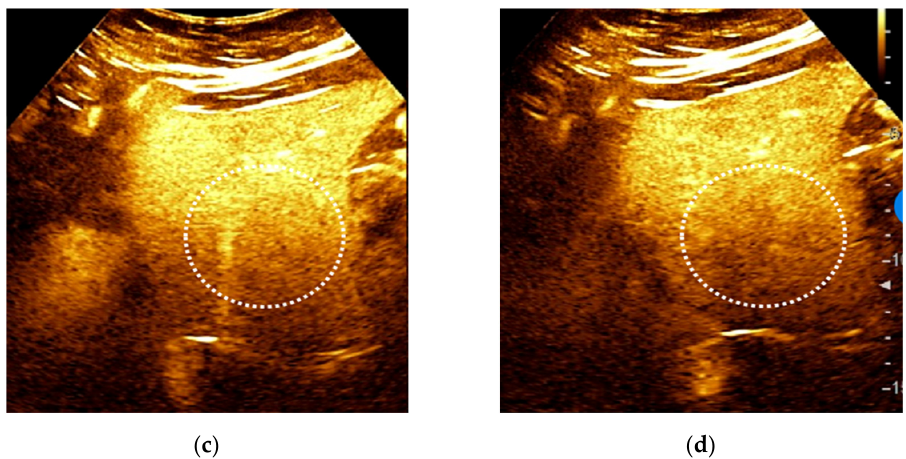
Figure 3. LIRADS 3 nodule in a chronic hepatitis B patient. An isoechoic liver nodule discovered on B-mode ultrasound ( a ) showed no APHE ( b ) and no washout of any type ( c , d ). Final histological diagnosis was HCC.